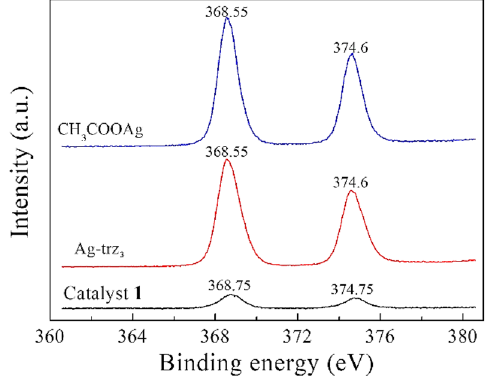
Figure 9. X-ray photoelectron Ag 3d spectra of catalyst 1 , Ag-trz 3 and CH 3 Figure 9. X-Ray photoelectron Ag 3d spectra of catalyst 1 , Ag-trz 3 and CH 3 COOAg.